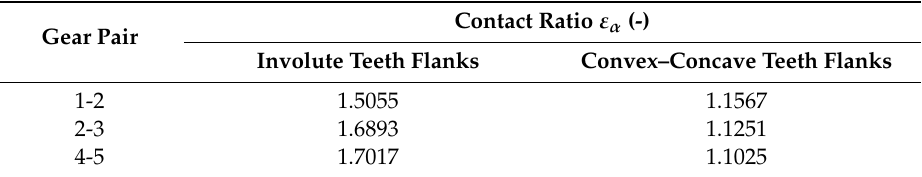
Table 5. Contact ratios of the partial gear pairs of the calculated